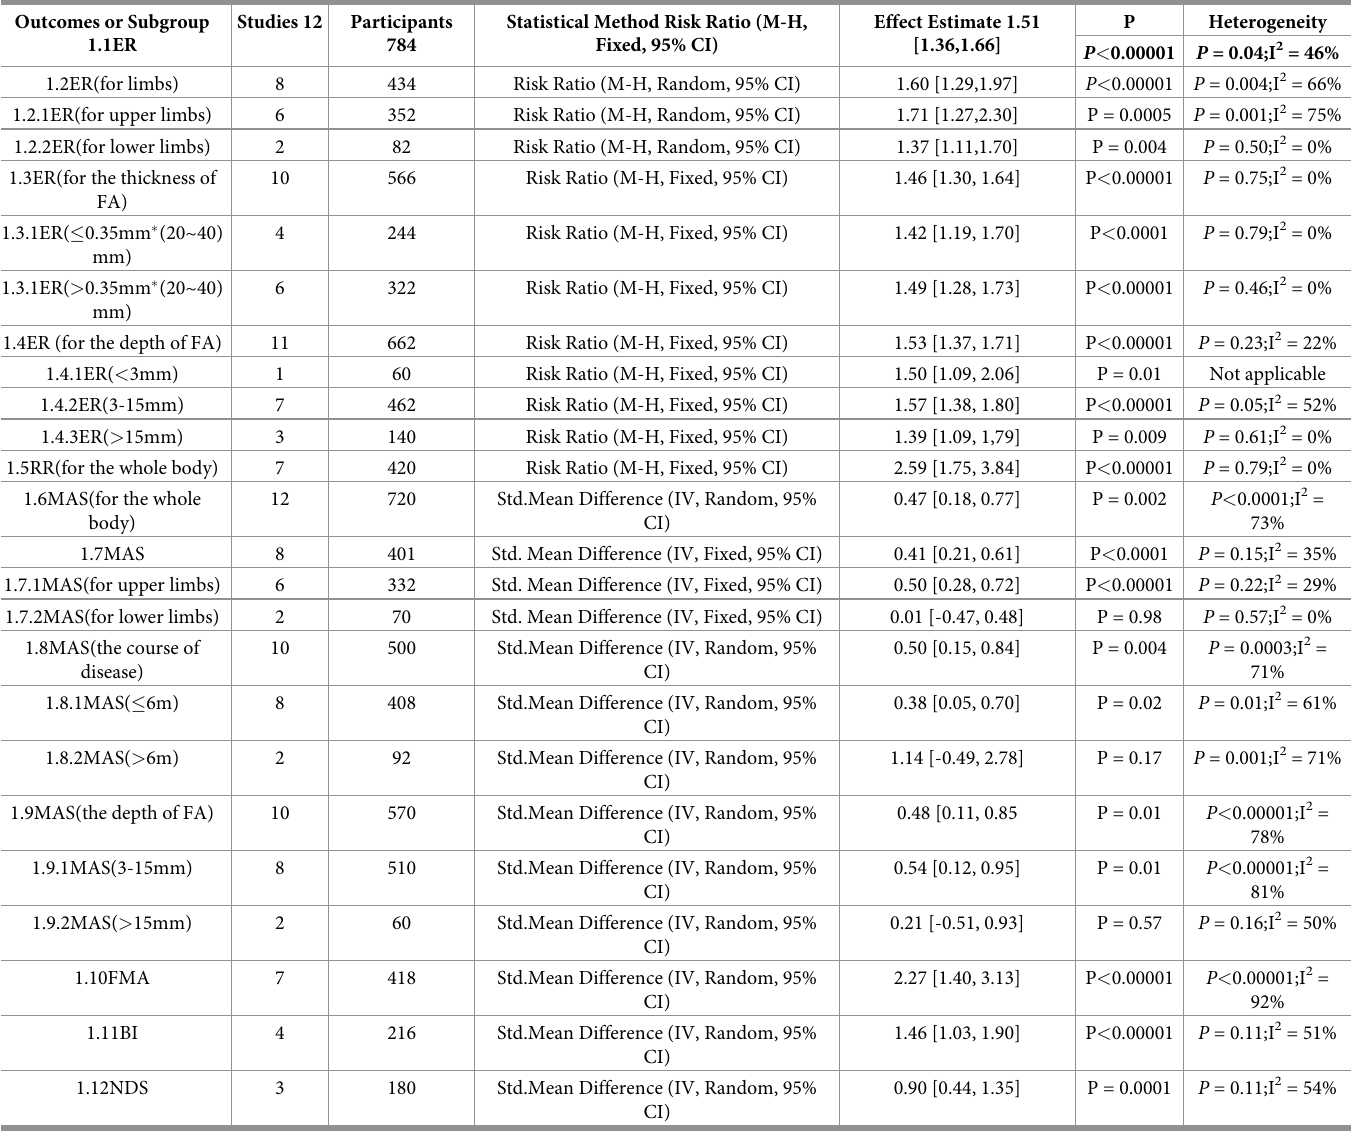
Table 6. Meta-analysis of the effects of fire acupuncture vs. electroacupuncture or acupuncture. Outcomes or Subgroup